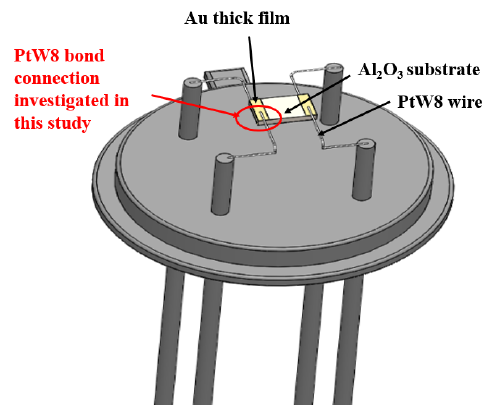
Figure 1. Schematic diagram of a typical planar parathermal gas sensor.